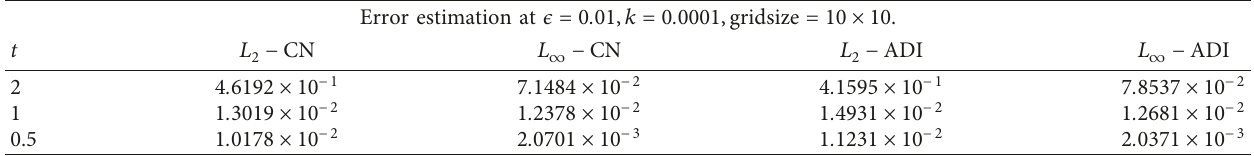
Table 2: Error profile data by using CN & ADI at t � 2 for unknown u ( p, q,t ) .